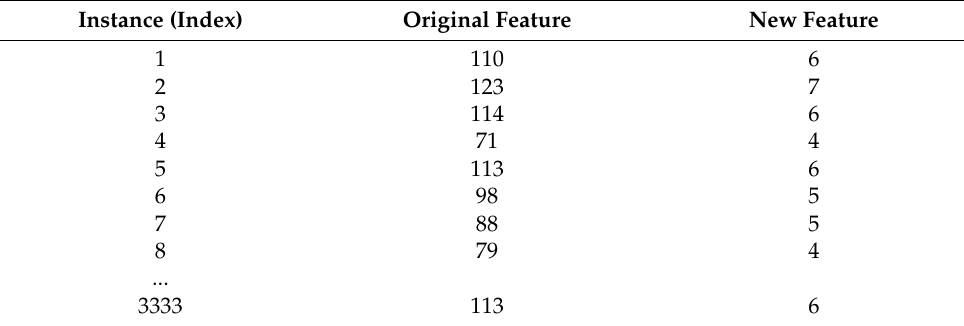
Table 3. The grouping results of the feature ‘Total day calls’.